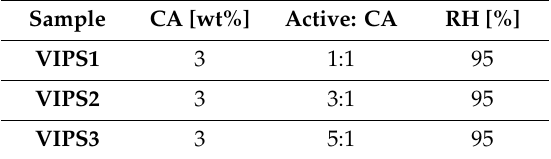
Table 1. Sample composition and process parameters of the VIPS microparticles.